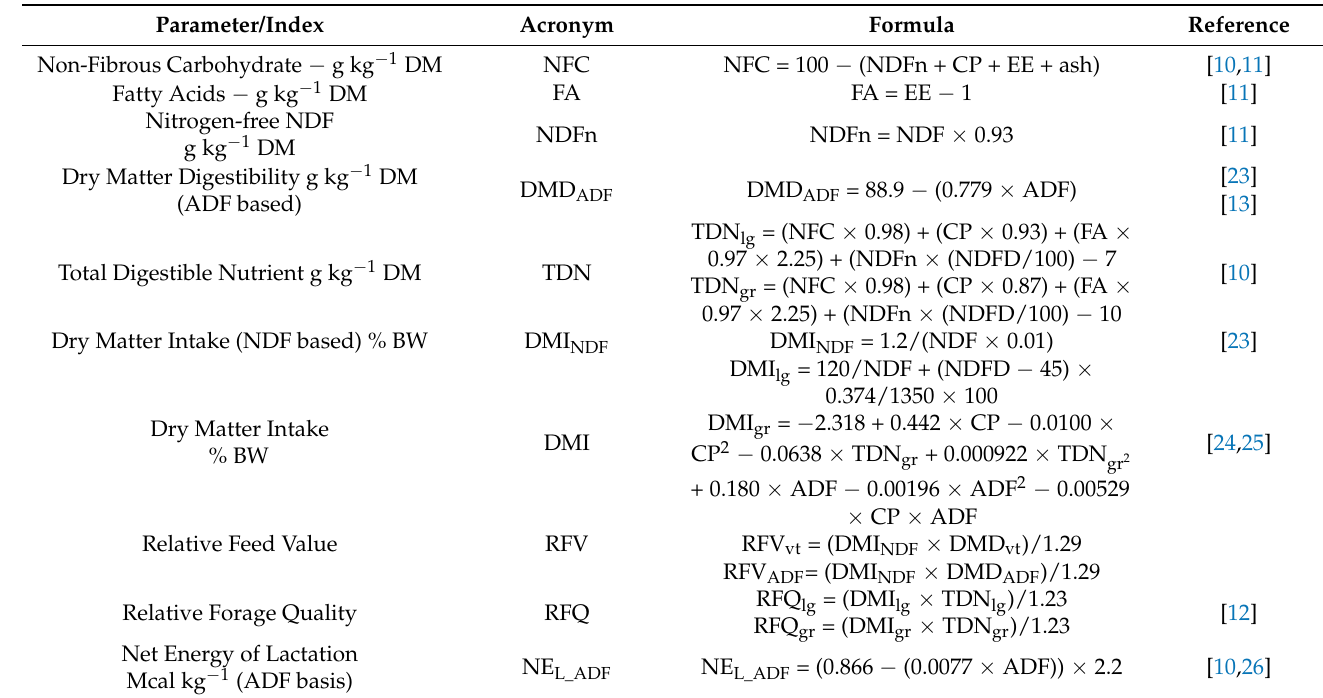
Table 2. Parameters and indexes calculated to estimate forage